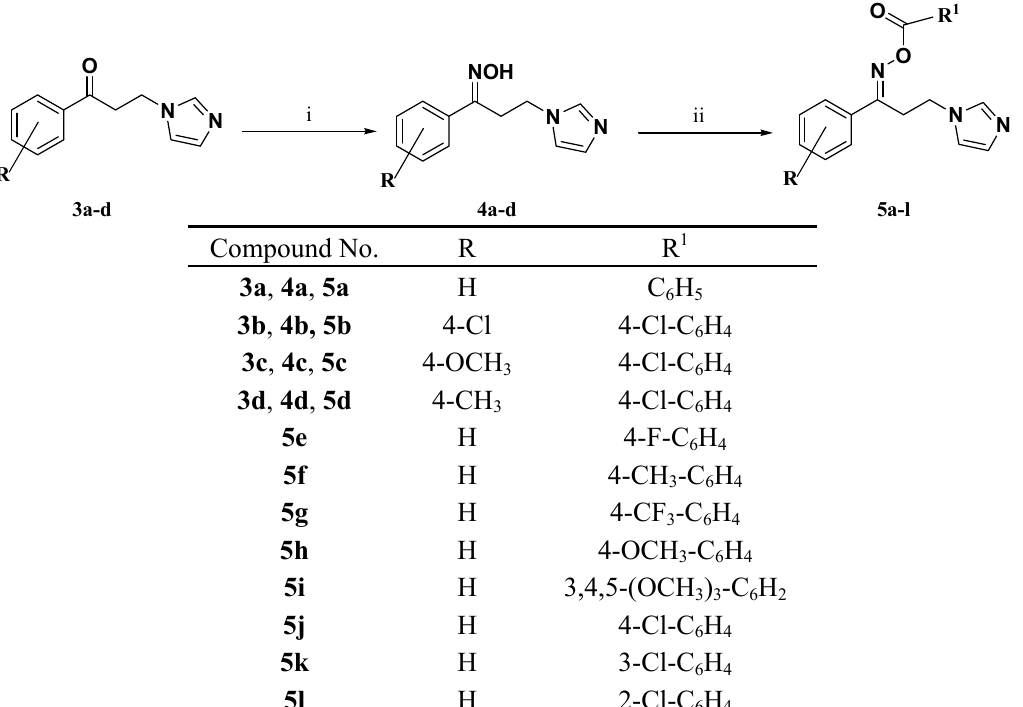
Scheme 2. Synthesis of the target compounds 5a – l